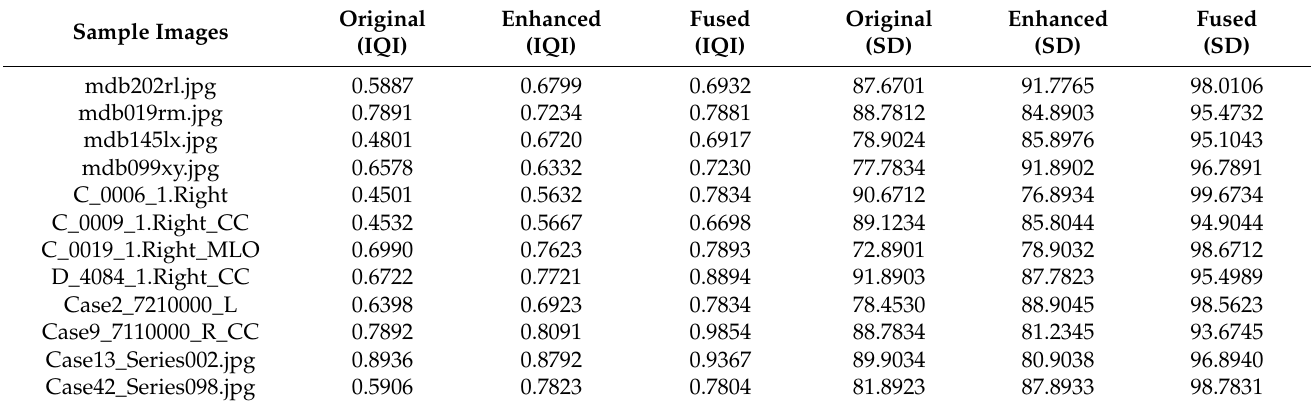
Table 2. Quantification of Fusion Response using IQI and